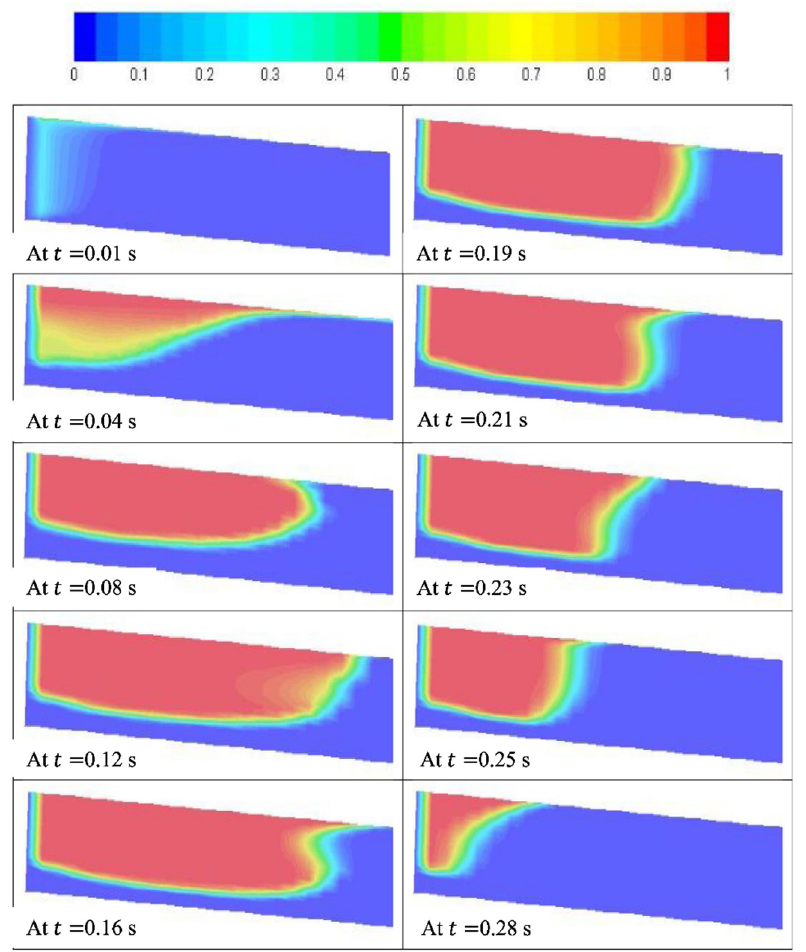
Figure 10. Cavity size evolution captured by CFD (Warda et al. [23]) .